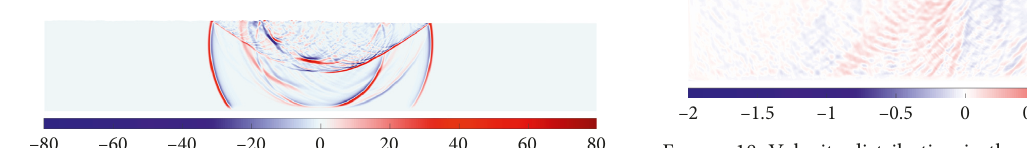
Figure 18: Velocity distribution in the x direction at time �